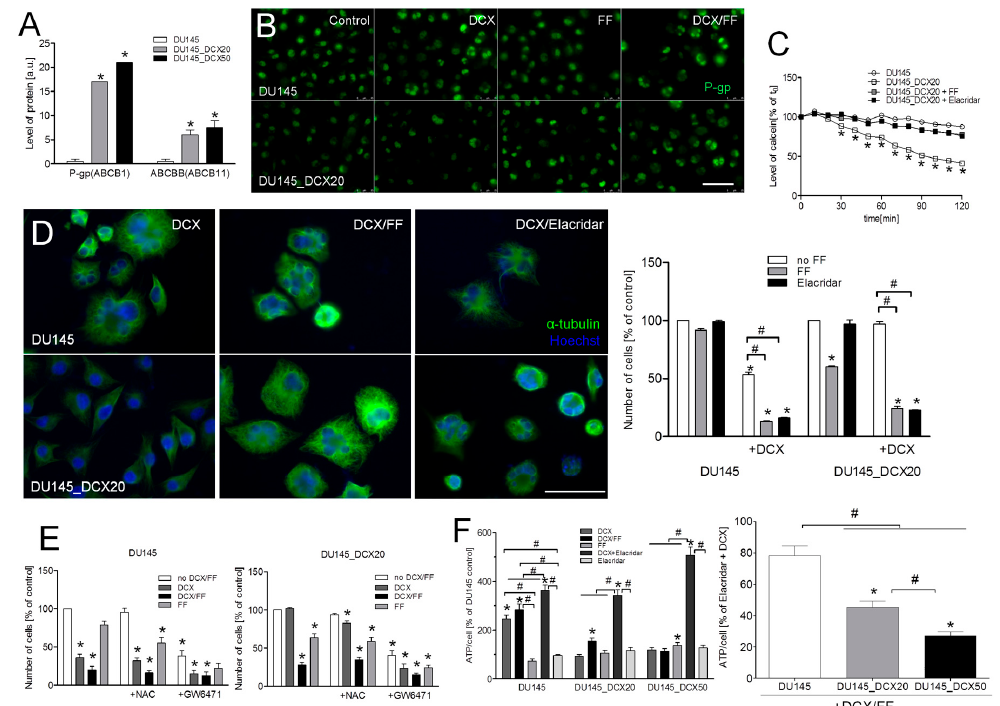
Figure 4. FF interferes with the activity of multi-drug resistance (MDR) transporters in DCX-resistant DU145 cells. ( A ) Abundance of the peptides identified by shotgun tandem mass spectrometry corresponding to of MDR protein levels in DU145 and DCX-resistant cells. MDR protein levels in DU145 and their DCX-resistant counterparts cells were identified according to semi-quantitative analysis of peptide-spectrum matches (PSMs) obtained in liquid chromatography-mass spectrometry LC–MS/MS measurements. ( B ) The effect of DCX/FF on the intracellular localization of P-gp was visualized with fluorescence microscopy in naïve DU145 and DU145_DCX20 cells 48 h after the administration of 2.5 nM DCX/25 µ M FF. ( C ) Naïve DU145 and DU145_DCX20 cells were incubated in the presence of elacridar (0.1 µ M) or FF (25 µ M). The efficiency of their efflux systems was measured by calcein efflux assay. ( D ) The effect of DCX/elacridar/FF on the architecture of microtubules in DU145 and DCX-resistant DU145 cells (left) and on their proliferation (right) was estimated with immunofluorescence and cell counting, respectively. ( E ) Naïve DU145 (left) and DU145_DCX20 cells (right) were incubated in the presence of DCX/FF and GW6471 (10 µ M) or N-acetyl-L-cysteine (1 mM; NAC), and their proliferation was estimated after 48 h (as % control). ( F ) The effect of elacridar (0.1 µ M) and/or 2.5 nM DCX/25 µ M FF on ATP levels was estimated in single DU145 and DCX-resistant DU145 cells after 48 h of incubation and calculated as % of the untreated control (left) and as % of DCX/elacridar-treated cells (right). Data representative of at least three independent experiments (N > 3). Error bars represent SEM. Statistical significance was analyzed with t-Student test vs. non-treated DU145 control, non-treated DU145_DCX20 control ( E ; right; * p ≤ 0.05) or vs. the variant indicated by the brackets ( # p ≤ 0.05). Scale bar: 50 ( D ) or 100 µ m ( B ). Note that the DCX-resistance of DU145_DCX20 and DU145_DCX50 cells correlates with relatively high activity of efflux systems in these cells. Inhibition of this system in DCX/FF-treated cells correlates with PPAR α /ROS-independent reduction of intracellular ATP